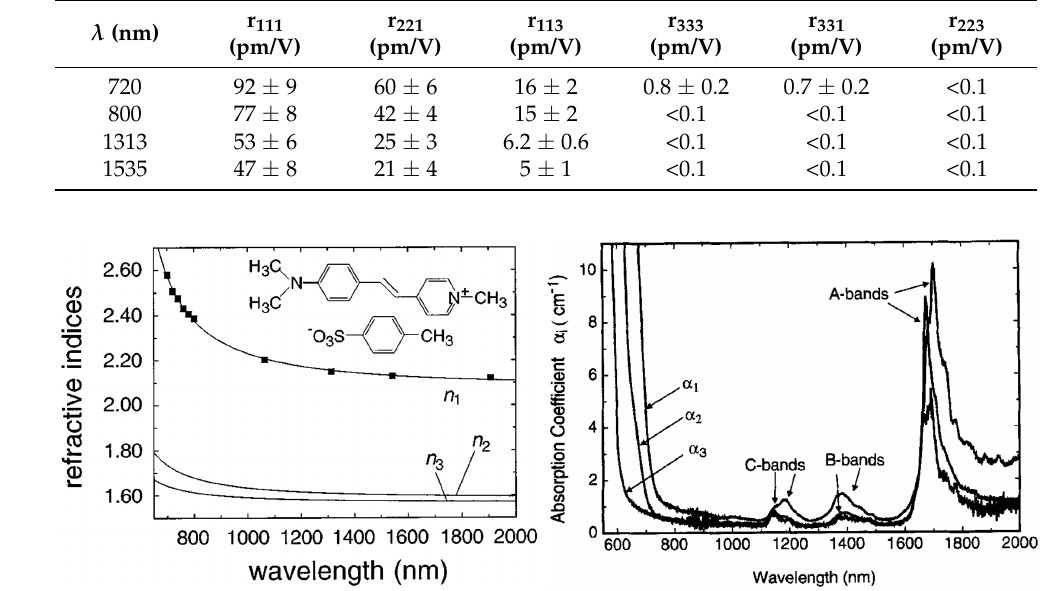
Figure 8. Refractive indices n 1 ( n x ), n 2 ( n y ), and n 3 ( n z ) of DAST. Reprinted from [93], with the permission of AIP Publishing. Absorption coefficients α 1 ( α x ), α 2 ( α y ), and α 3 ( α z ) of DAST. Reprinted from [173], with the permission of John Wiley and Sons.